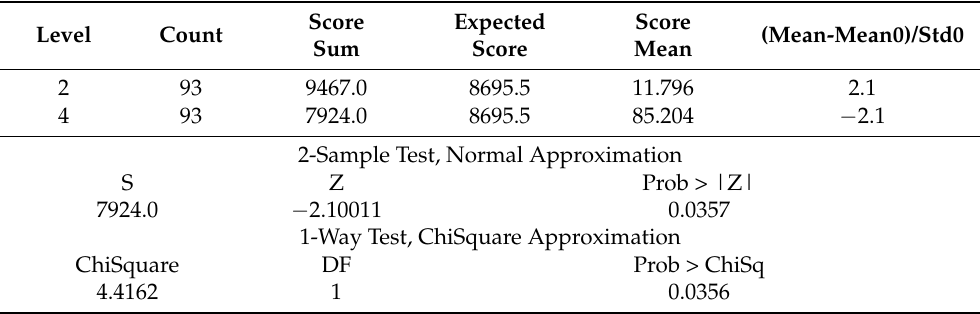
Figure 6. Variability analyses PID with the influence of the date. Table 7. Result Kruskal–Wallis tests—analysis of variability PID with the influence of the date. Table 5. Result of Kruskal–Wallis tests—analysis of CO 2 variability with the influence of the date. ChiSquare DF Prob ChiSq 45.8965